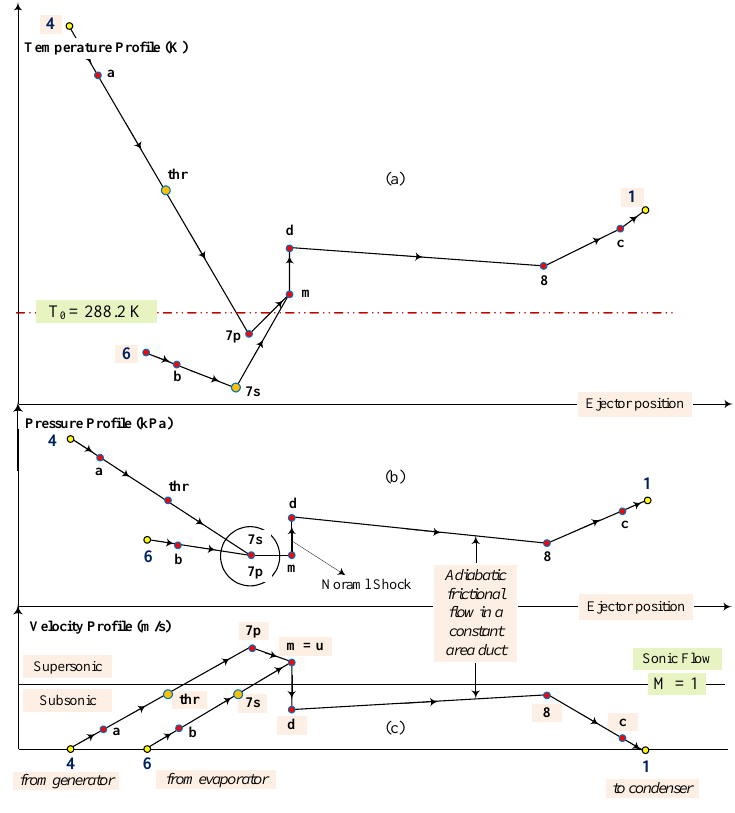
Figure 4. Temperature ( a ), Pressure ( b ) and Velocity ( c ) profiles along the ejector.